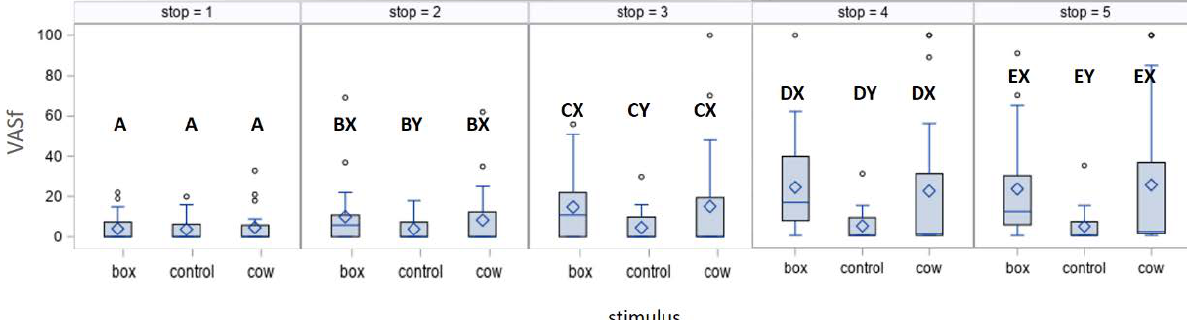
Figure 3. The assessment of fearfulness of horses (VASf) exposed to different stimuli at stops from the furthest (Stop1) to the nearest (Stop5). Scores with A–E letters differ significantly at p < 0.01 between stops; scores with X, Y letters differ significantly at p < 0.01 between stimuli; values with no letter do not differ to other values. Diamonds represent median values, borders of boxes occur at upper and lower quartiles and blue lines indicate maximum and minimum values. Circles show outliers.